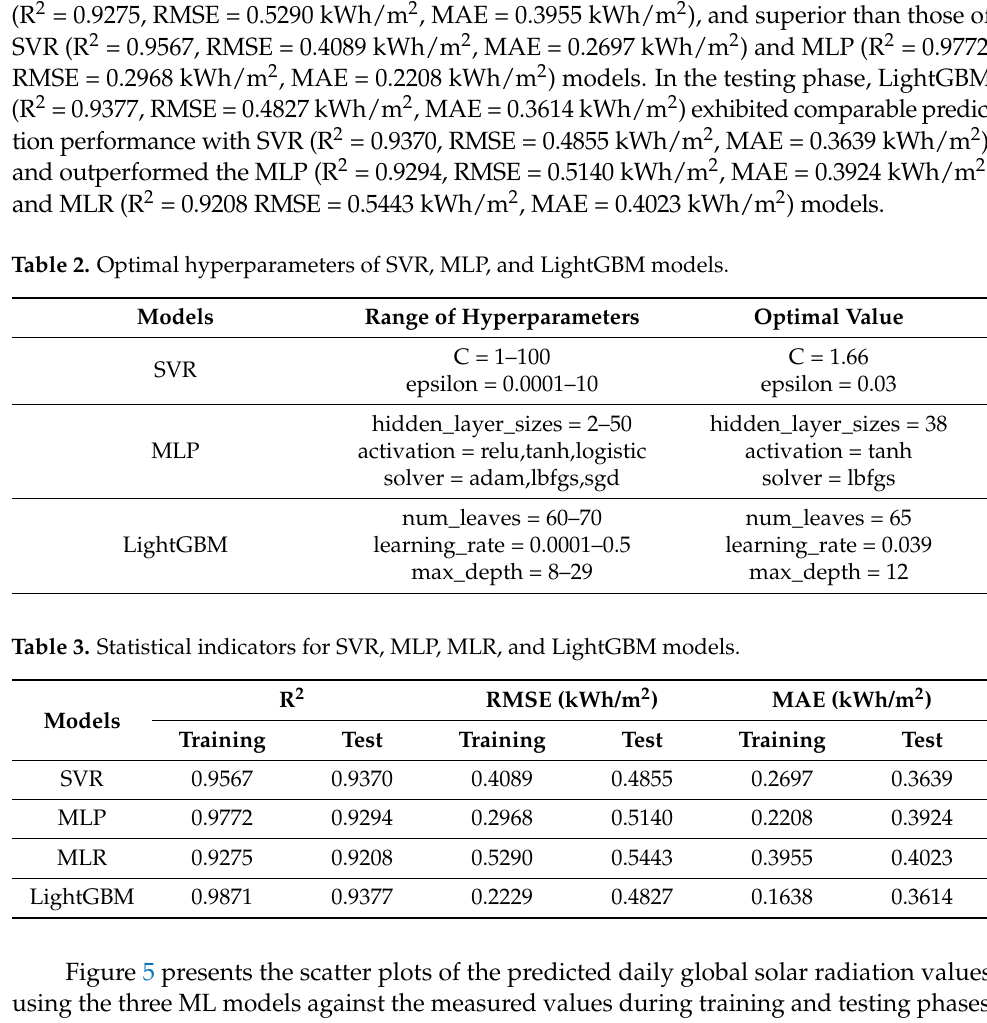
MAE = 0.1638 kWh/m 2 ) in the training phase were significantly better than those of MLR (R 2 = 0.9275, RMSE = 0.5290 kWh/m 2 , MAE = 0.3955 kWh/m 2 ), and superior than those of SVR (R 2 = 0.9567, RMSE = 0.4089 kWh/m 2 , MAE = 0.2697 kWh/m 2 ) and MLP (R 2 = 0.9772, RMSE = 0.2968 kWh/m 2 , MAE = 0.2208 kWh/m 2 ) models. In the testing phase, LightGBM (R 2 = 0.9377, RMSE = 0.4827 kWh/m 2 , MAE = 0.3614 kWh/m 2 ) exhibited comparable predic- tion performance with SVR (R 2 = 0.9370, RMSE = 0.4855 kWh/m 2 , MAE = 0.3639 kWh/m 2 ), and outperformed the MLP (R 2 = 0.9294, RMSE = 0.5140 kWh/m 2 , MAE = 0.3924 kWh/m 2 )